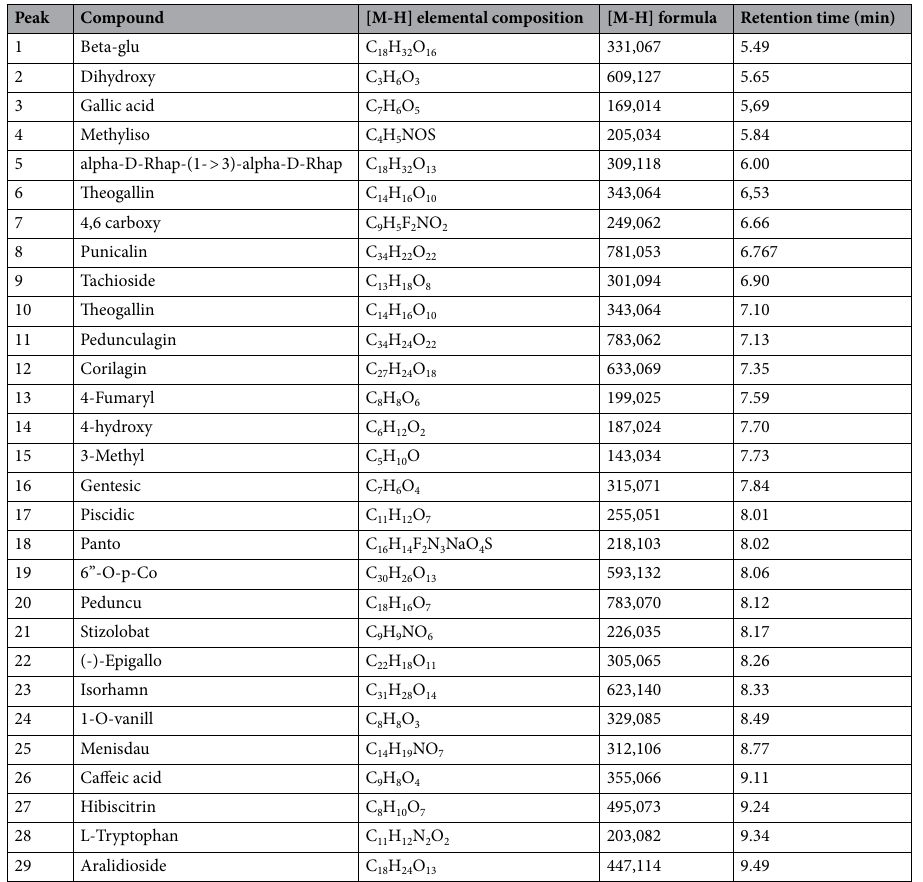
Table 3. Compounds detected in ten plant species used as ethnoveterinary medicines in Omusati and Kunene regions of